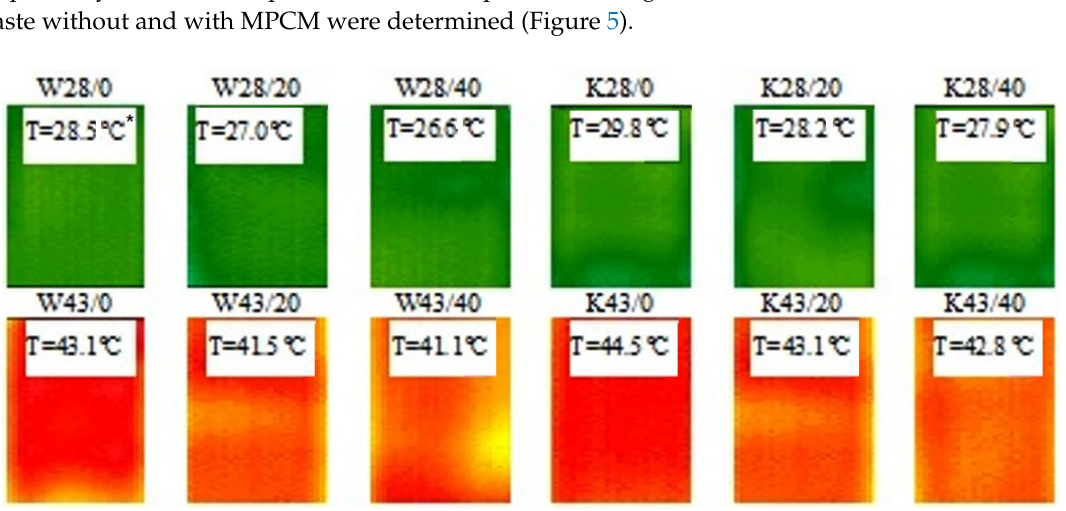
Figure 3. Coefficient of thermal efficiency of melting ( X m ) and crystallization ( X c ) process fortextile Figure 3. Coe ffi cient of thermal e ffi ciency of melting ( X m ) and crystallization ( X c ) process fortextile materials modified with MPCM28 and MPCM43. materials modified with MPCM28 and MPCM43.